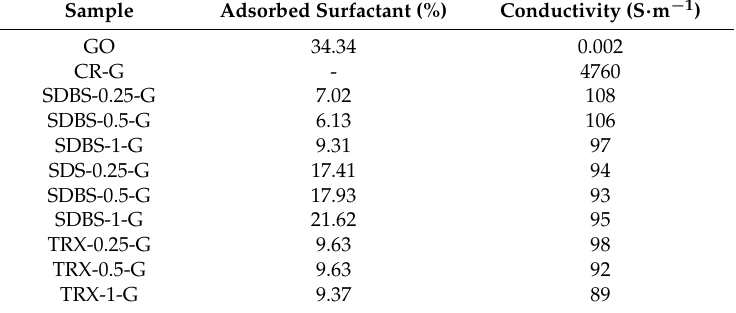
Table 4. Comparison of materials of absorbed surfactant and electrical conductivity. Reproduced with permission from Md. Elias Uddin et al., Journal of Alloys and Compounds; published by Elsevier, 2013